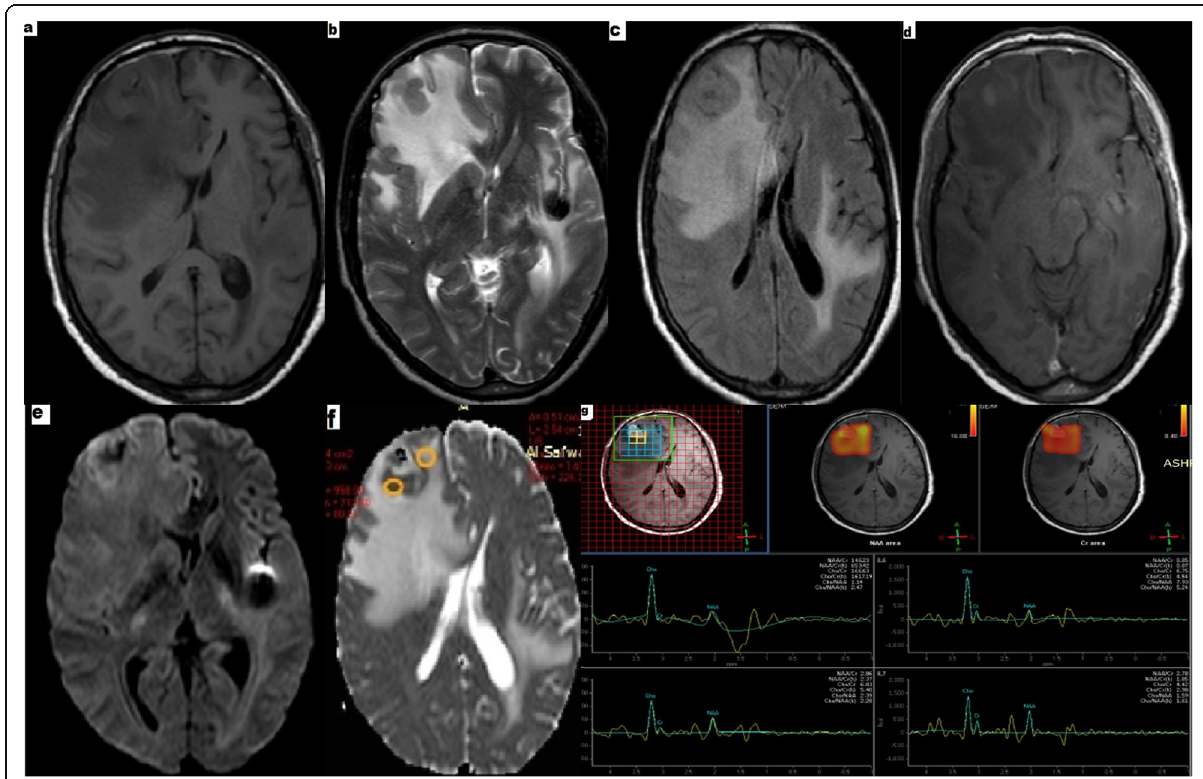
Fig. 1 “ A 54-year-old male patient ” MRI exam revealed multiple poorly defined intra-axial SOL shown in images at Rt. frontal and Lt. parietal regions, iso-hypointense at T1 ( a ) and hyperintense T2/FLAIR ( b , c ) that surrounded with moderate edema. DWI and ADC map ( d , e ) showed diffusion restriction with low ADC value. Post Gad ( f ) showed faint contrast enhancement. MRS ( g ) revealed marked reduction of NAA and Cr peaks with elevated Cho and reversed NAC/Cr and Chol/Cr ratios in lesional and pre-lesional areas. MRI diagnosis: multicentric primary high-grade glioma. Pathology: